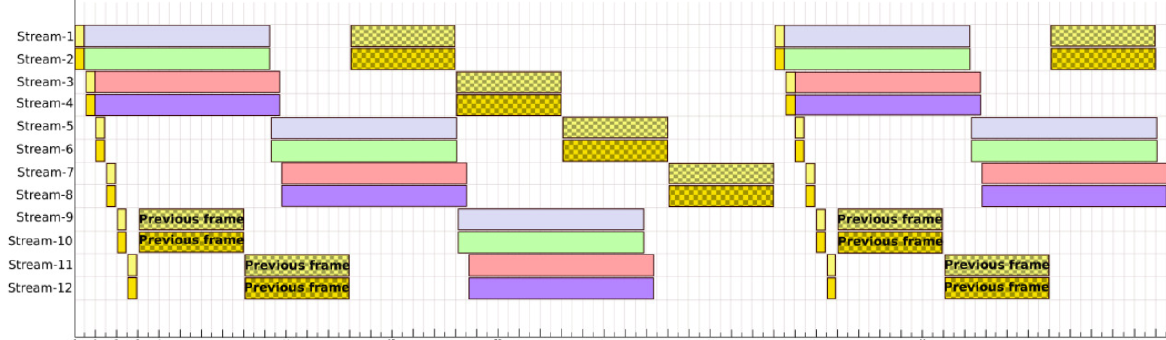
Figure 13. Stream processing schedule using CPU and VPU cores.